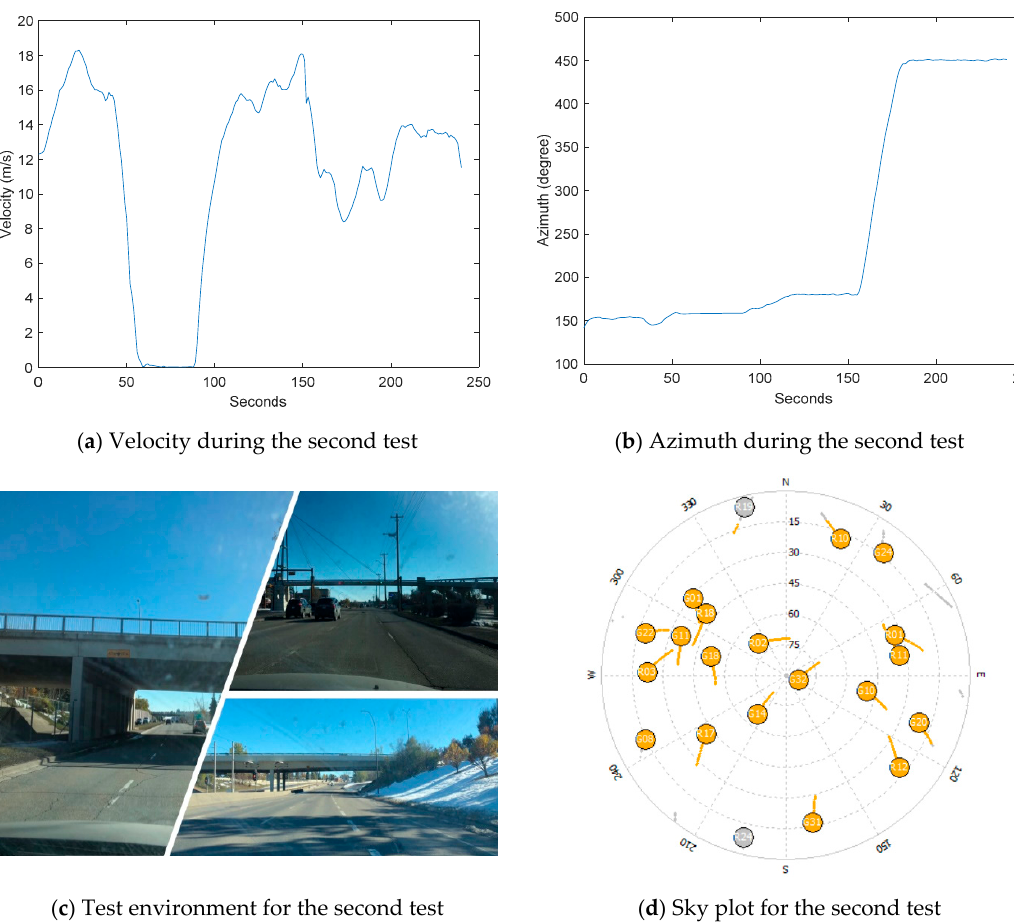
Figure 10. Velocity, azimuth, environment, and sky plot of the satellites for the second test. The trajectories and the horizontal errors using different satellites are plotted in Figures 11 and 12, respectively. The sudden accuracy change around 150 s was due to passing through one bridge, and moving direction change after that. In addition to this, the trajectory using 1 GPS satellite and 2 GLONASS satellites had another sudden change at about 125 s. This is because one of the GLONASS satellites used was changed because of the elevation change. The second-highest GLONASS satellite was changed from R17 to R18. Therefore, the performance was highly related to the orientation of the satellites used. The RMS, maximum errors, and relative horizontal positioning errors of each trajectory are summarized in Table 3. Generally, better results could be expected with more satellites used. With one satellite used, the horizontal accuracy was not improved. When 2 or more satellites, especially GPS satellites, were applied, the horizontal accuracy had an evident improvement. The largest drift was only 5 m when 3 GPS satellites were